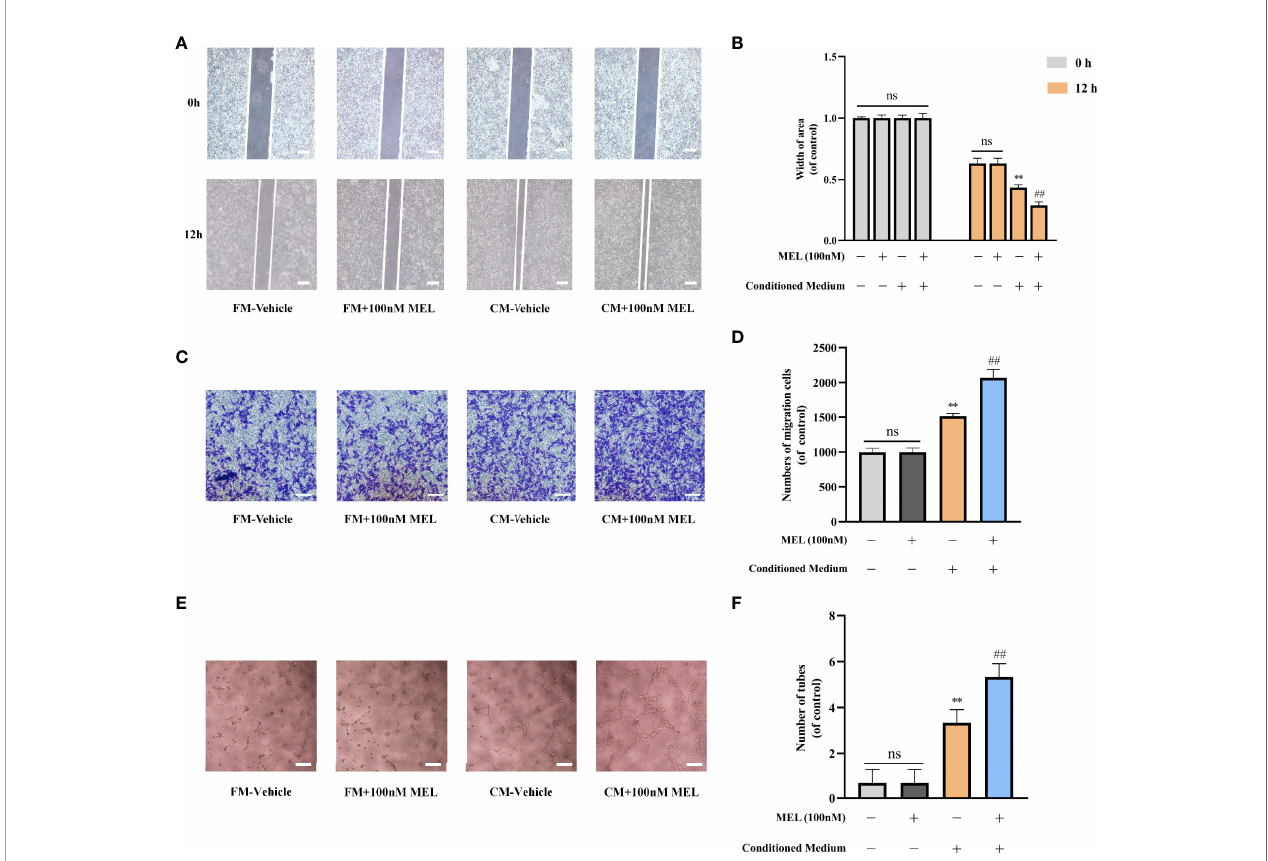
FIGURE 3 | Melatonin promoted osteogenesis-angiogenesis coupling in vitro . (A, B) Scratch wound assay of HUVECs incubated with the indicated mediums (scale bars, 100 m m). (C, D) Transwell migration assay of HUVECs incubated with the indicated mediums (scale bars, 100 m m). (E, F) Tube formation assay of HUVECs incubated with the indicated mediums (scale bars, 100 m m). All the experiments were repeated at least 3 times independently. The data are presented as means ± SEM. ** p < 0.01 vs . control group, ## p < 0.01 vs . CM-vehicle group. HUVECs, human umbilical vein endothelial cells; FM, fresh medium; CM, conditioned medium. ns, no signi fi